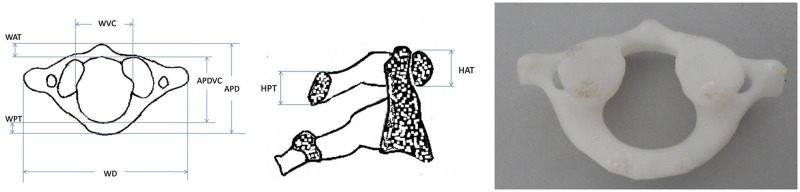
Schematic diagram showing the method of measurement for C1 (Atlas).
WD is the abbreviation of Width diameter; APD is Anteroposterior diameter; WVC is Width of vertebral canal; APDVC is Anteroposterior diameter of vertebral canal; WAT is Width of anterior tubercle; HAT is Height of anterior tubercle; WPT is Width of posterior tubercle; and HPT is Height of posterior tubercle.